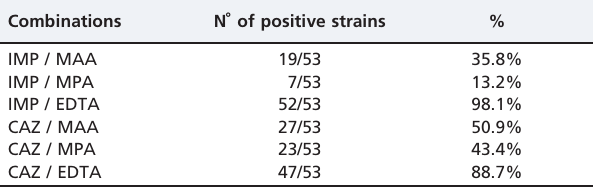
Table 1 - Positivity of inhibitor-substrate combinations on DDS used for detecting MBL among 69 IRPA isolates.